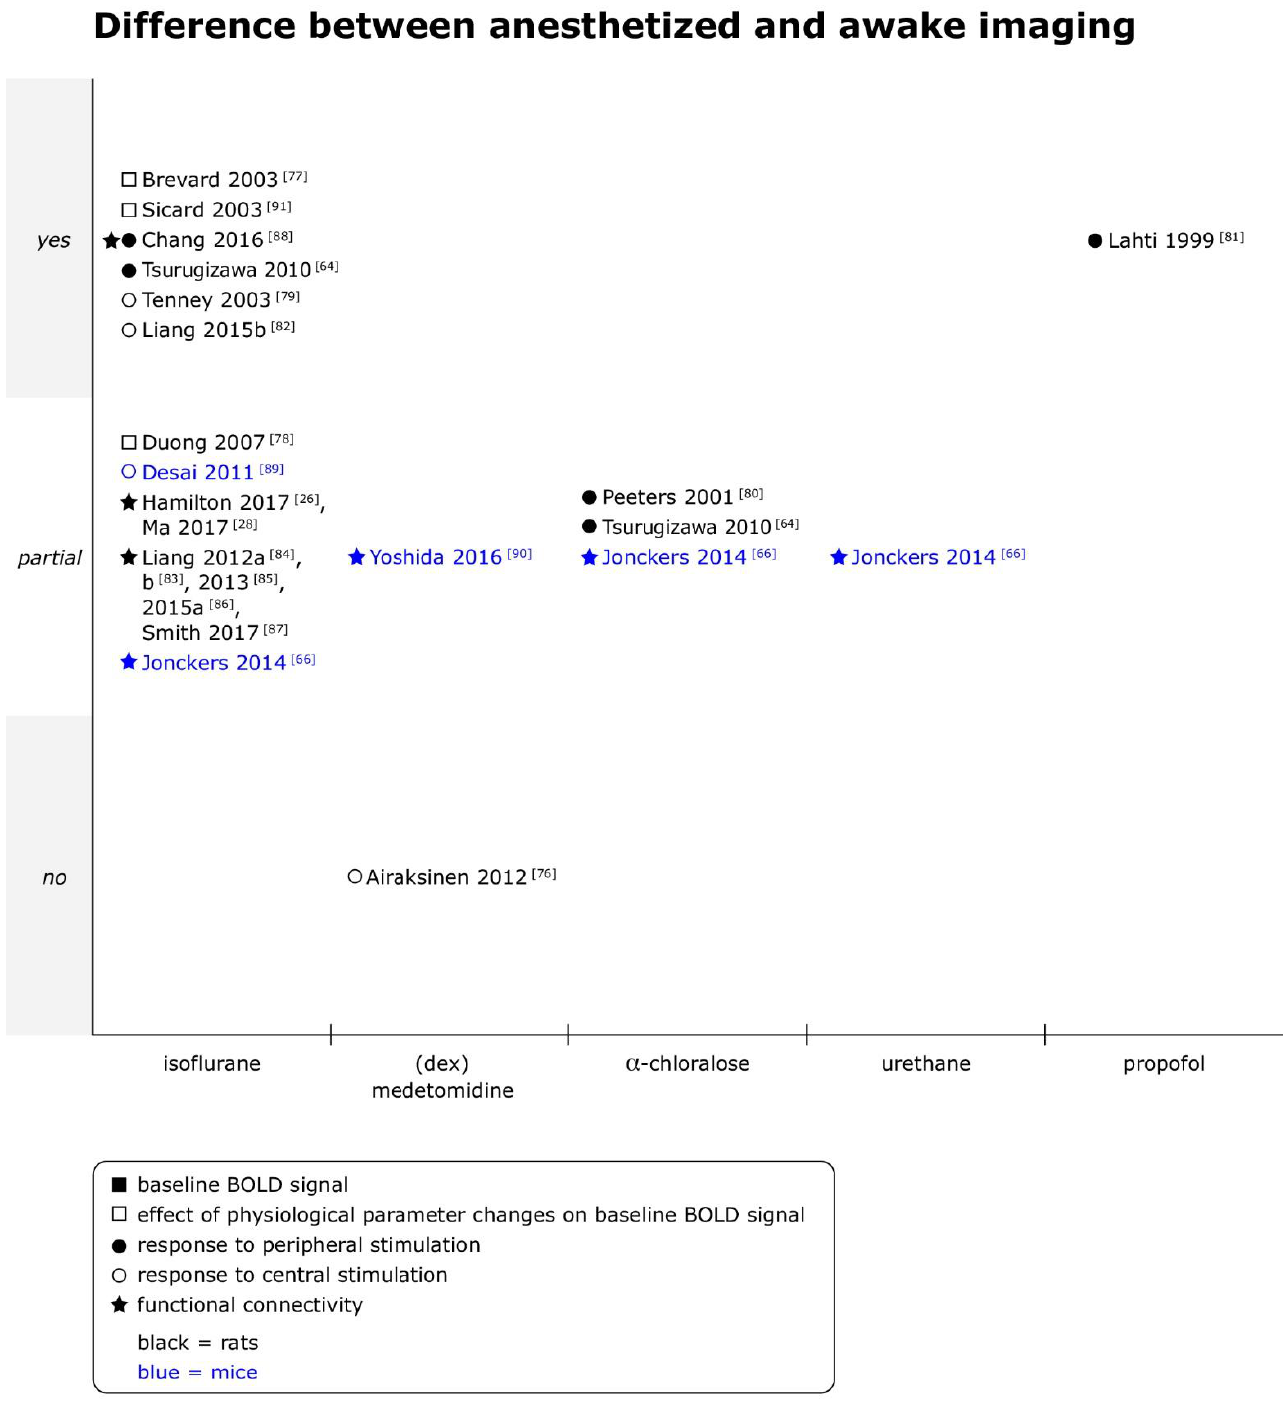
Figure 4. Comparison of anesthetized versus awake imaging for baseline BOLD signal, responses to peripheral and central stimulation and functional connectivity in rats and mice. Yes = differences between anesthetized and awake imaging were clearly observed; partial = differences between anesthetized and awake imaging were observed for some outcomes, analyses or animals, but not consistently, or quantitative differences were reported, but statistical significance unclear; and no = no differences between anesthetized and awake imaging were observed. When datasets were re-analyzed, findings were pooled and one data point per specific comparison (i.e., per anesthetic per type of fMRI) displayed. (dex)medetomidine = medetomidine or dexmedetomidine was studied. A summary of the main findings as well as the doses of anesthetics are provided for references with the symbols ◼ or in Supplementary Materials Tables S2 and S5, with symbols ⚫ or in Supplementary Materials Tables S3 and S5, and for references with symbol in Supplementary Materials Tables S4 and S6.